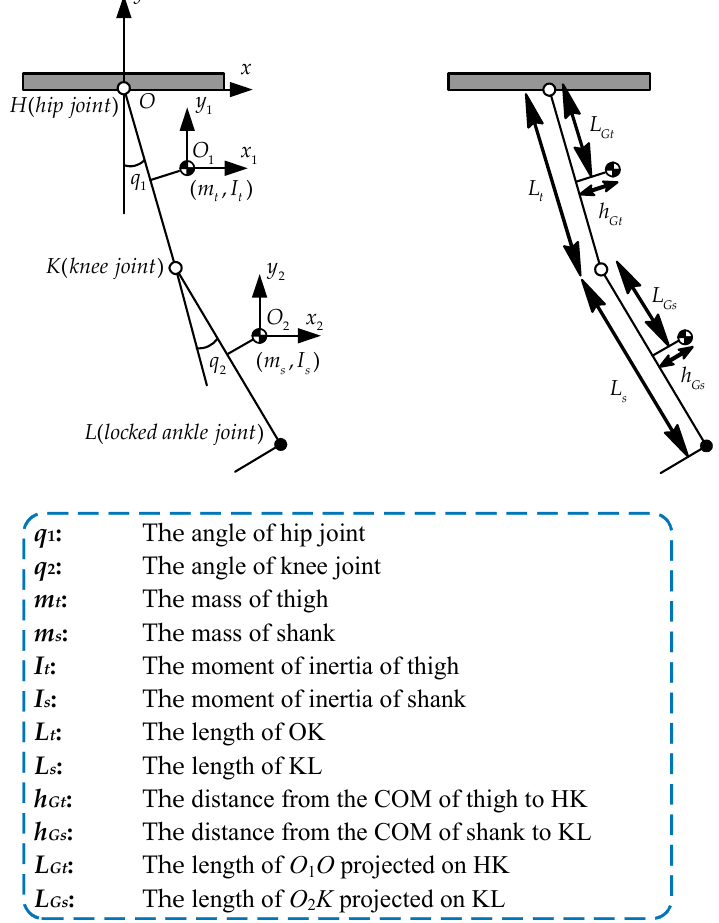
Figure 2. Simplified model of APAL’s lower extremity.